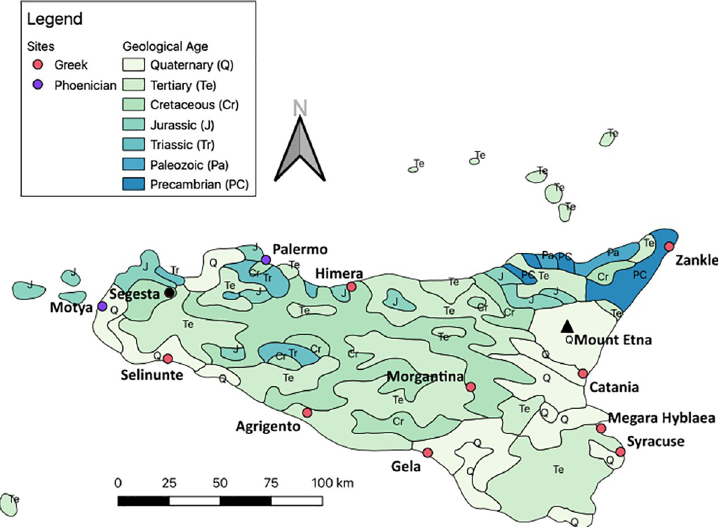
Fig 2. Map depicting geologic ages of the underlying bedrock in Sicily. Youngest deposits are represented by the lightest color and get darker with older geologic ages. Created in QGIS using DataSource: USGS [39] by KLR.